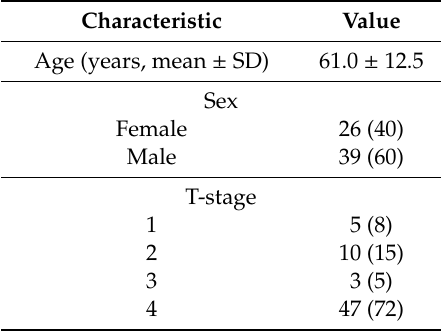
Table 1. Patient clinicopathologic and imaging